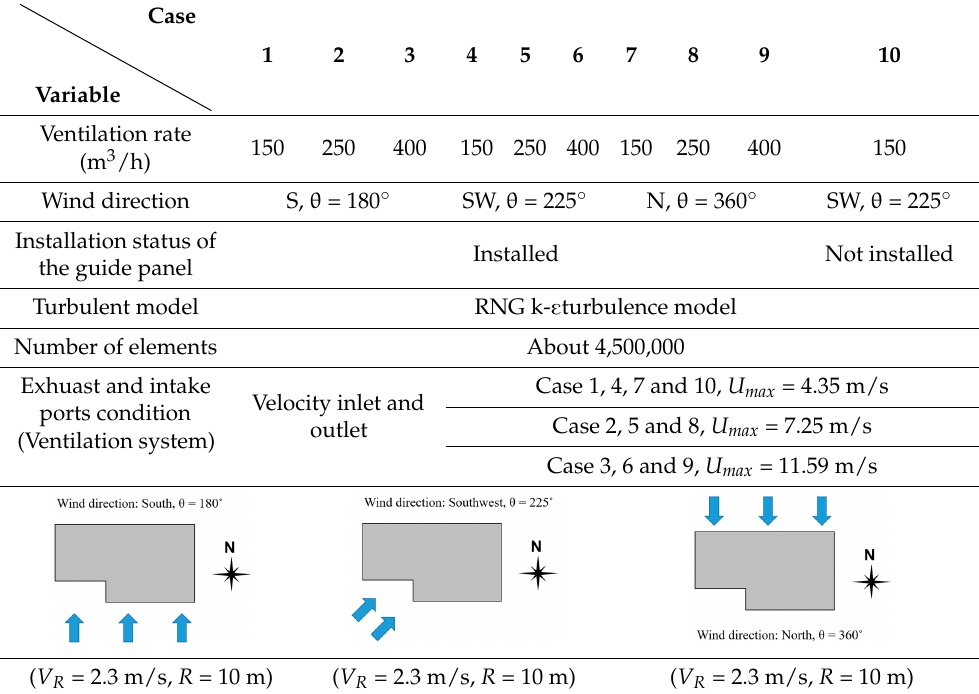
Table 1. Cases and boundary condition for CFD analysis.